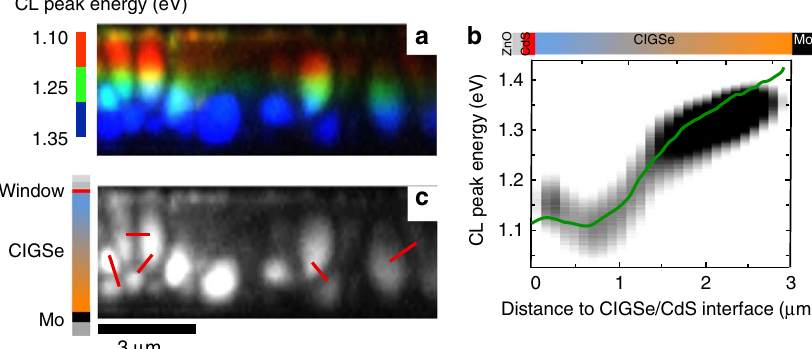
Fig. 3 Cathodoluminescence results. a Hyperspectral map acquired at 10 keV representing the peak energies in the CL spectra by false colors, which can be (roughly) assigned to the band-gap energies at the corresponding positions in the map. b Linescan extracted from the hyperspectral CL map, showing presumably the distribution of the CL peak energies perpendicular to the substrate, which agrees well with the one expected from the Ga distribution (green, given in Fig. 2d). c CL intensity map, where the red lines mark the positions at which pro fi les were extracted across grain